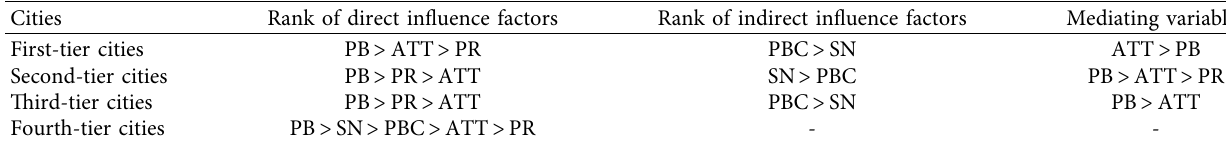
Table 7: Comparison of influence degree of psychological